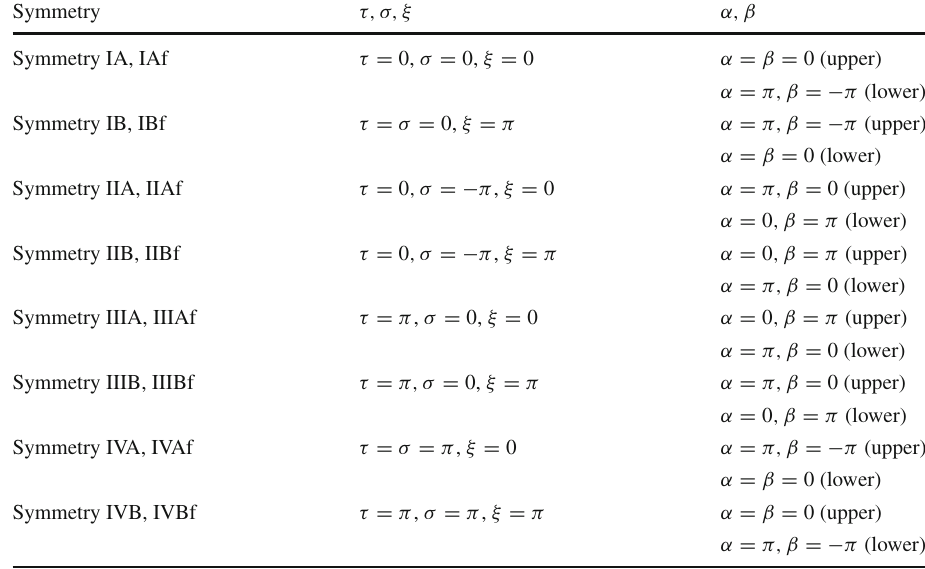
between the solutions given in Table 1 and the parameters of the SF equation. The labels “upper” and “lower” imply the upper and lower sign in the corresponding columns